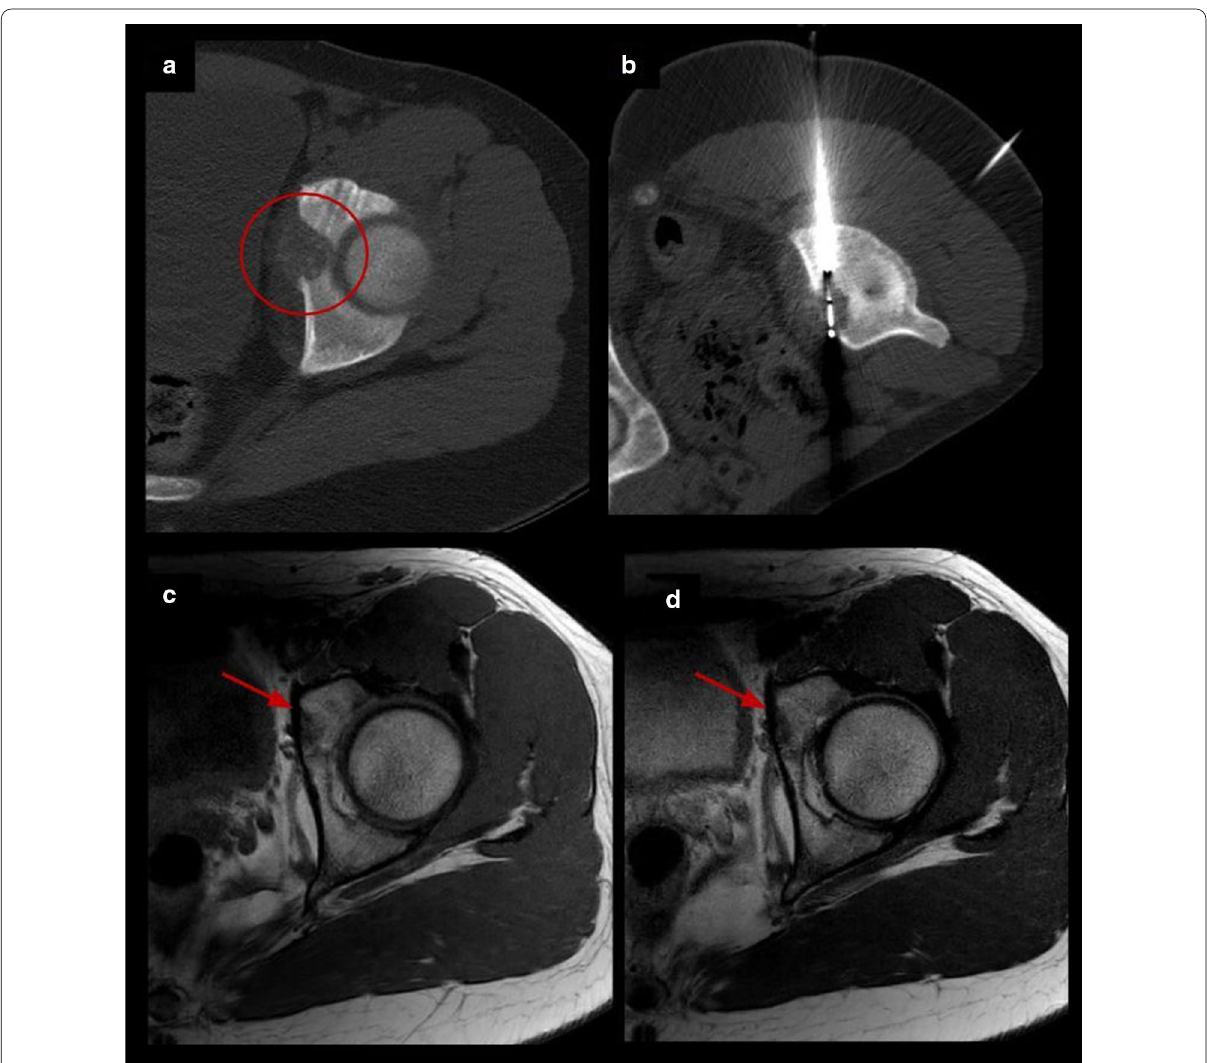
Fig. 5 Acetabulum osteoblastoma cryoablation. a Axial CT images demonstrating an expansive osteolytic tumor with partial matrix mineralization in the left acetabulum corresponding to osteoblastoma (circle). b Axial CT exhibiting one cryoprobe placed within the nidus. c, d Follow‑up MRI images 15 months after treatment with complete resolution of the lesion